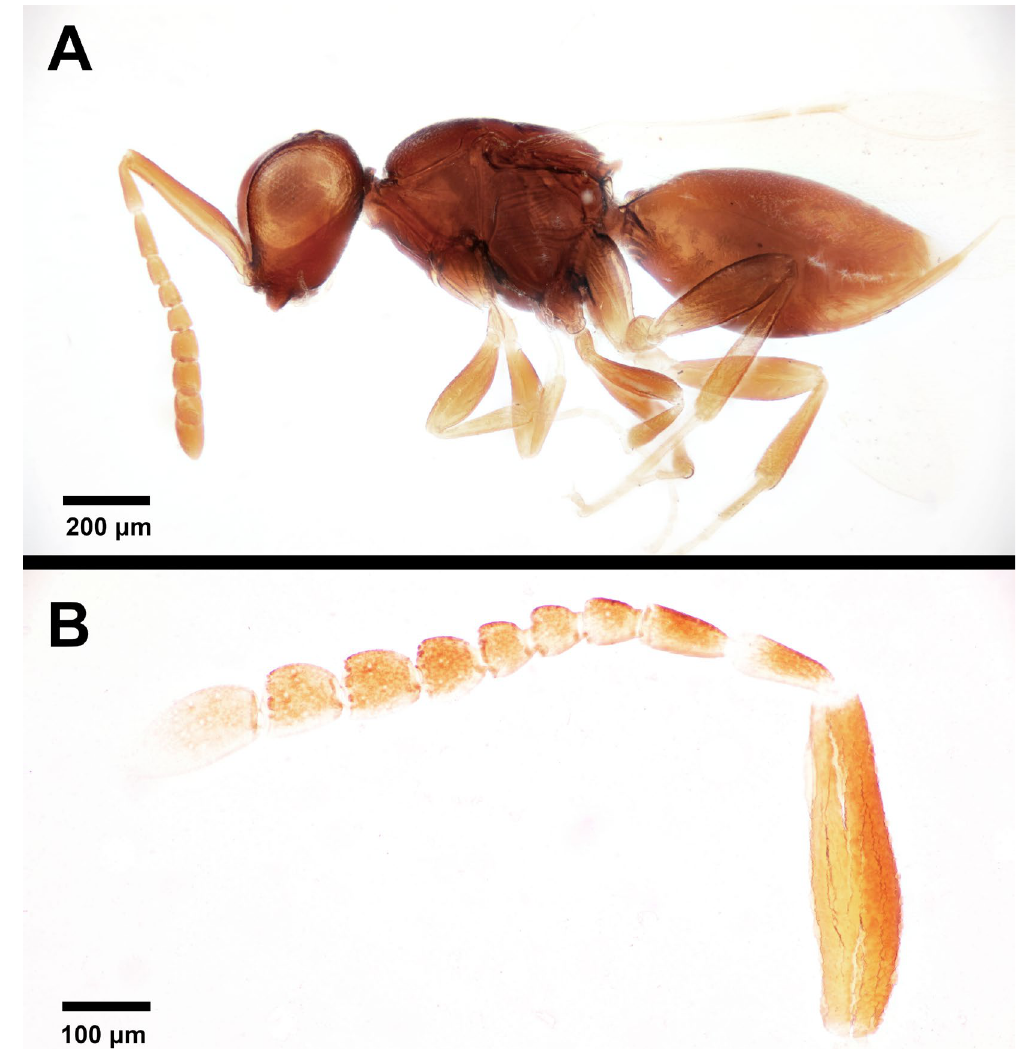
Fig. 9. Ceraphron alticola kieffer, 1913, syntype, ♀. A . Lateral view (MNhN EY25359). B . right antenna (MNhN